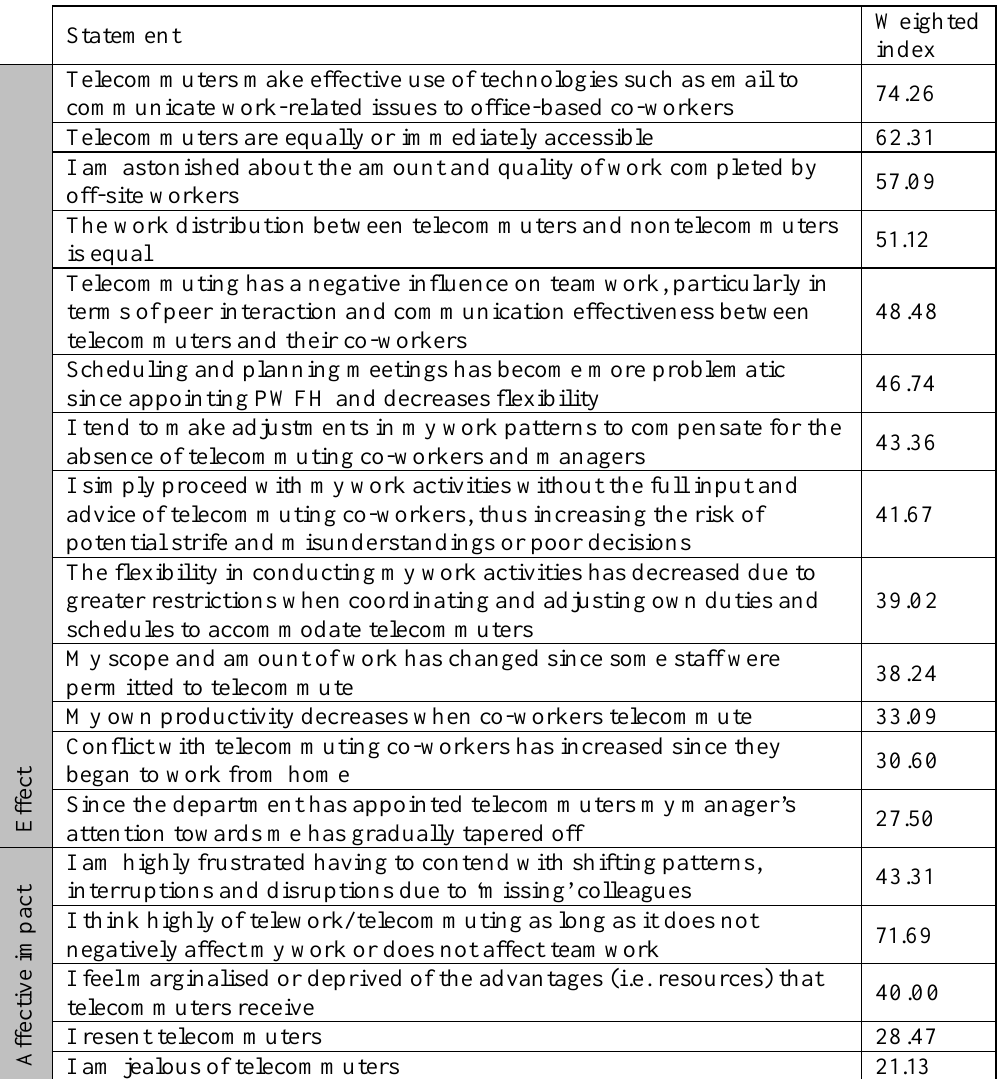
Effect and Affective Impact of Telecommuting Practices on Office-Based